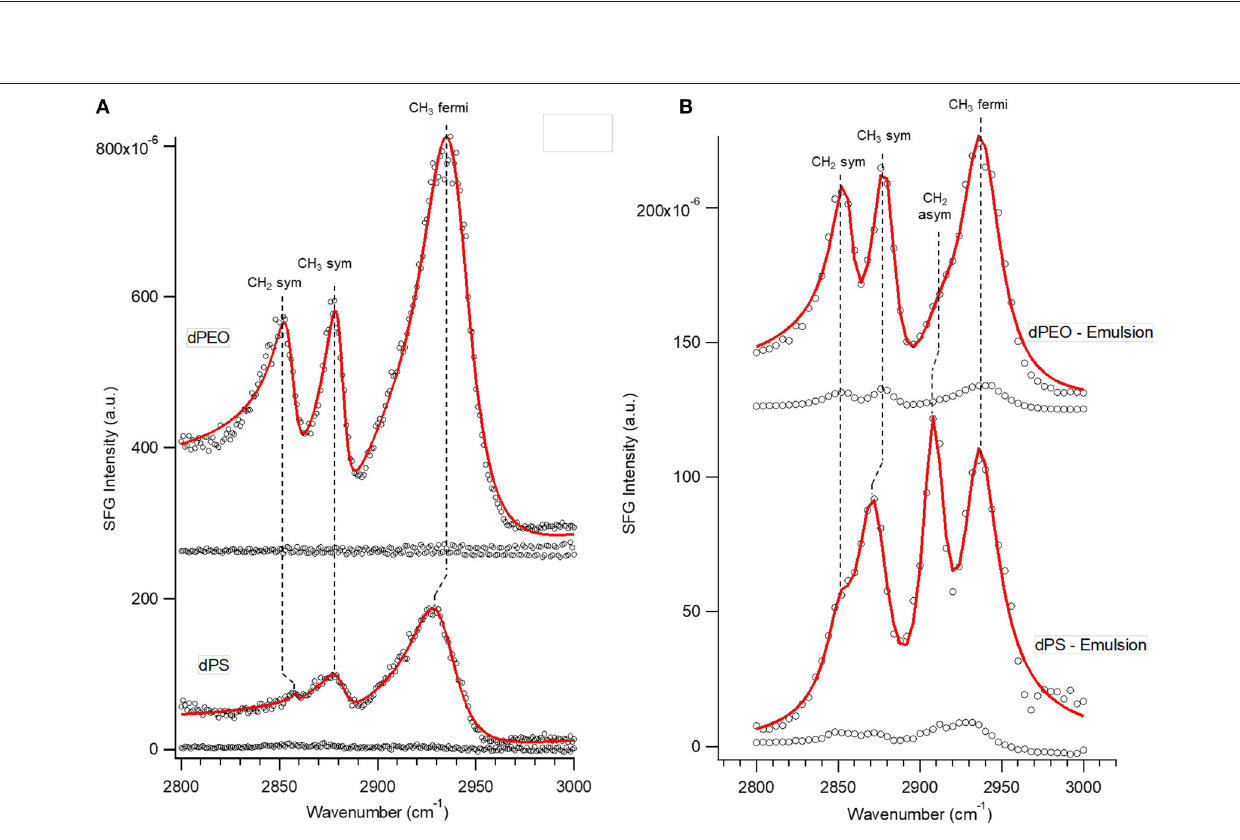
Frontiers in Mechanical Engineering |